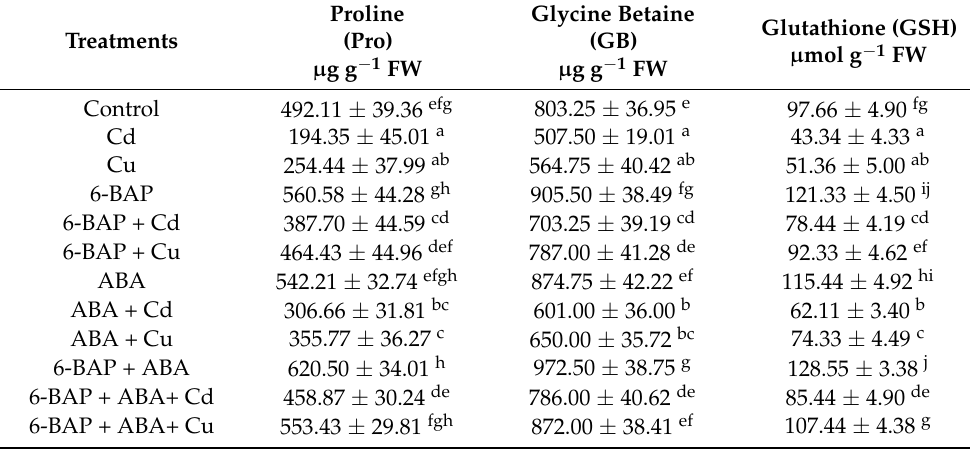
Table 5. The impact of 6-benzylaminopurine and abscisic acid, alone and in combination, on proline (Pro), glycine betaine (GB), and glutathione (GSH) content in the one-year-old Pleioblastus pygmaeus exposed to 100 µ M Cd and 100 µ M Cu. In this table, a, b, c, etc. letters revealed significant differences between the treatments according to Tukey’s test ( p < 0.05).